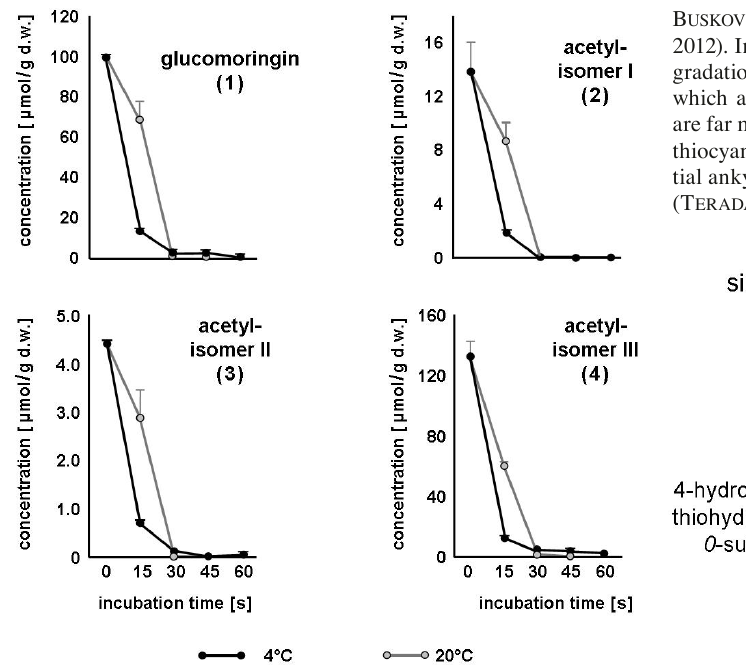
Fig. 4: LC-MS analysis of glucosinolates in M. oleifera extracts. Lyo- philized plant material from the greenhouse was incubated for 15 to 60 s either at 4 °C (black line) or at 20 °C (grey line), respectively. Data points represent the mean of three technical replicates for each glucosinolate. Contents were calculated with the standard curve of sinigrin.